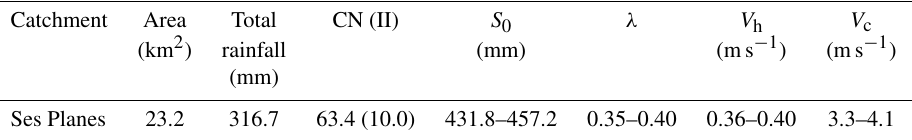
Table 1. Range of the calibrated parameters according to FEST and KLEM hydrological models. Total rainfall amount and curve numbers are expressed as area-averaged values. CN standard deviation is shown between brackets. Note that initial CNs correspond to normal antecedent conditions. V c corresponds to the maximum channel velocities for